Question: Produce a descriptive caption suitable for publication.
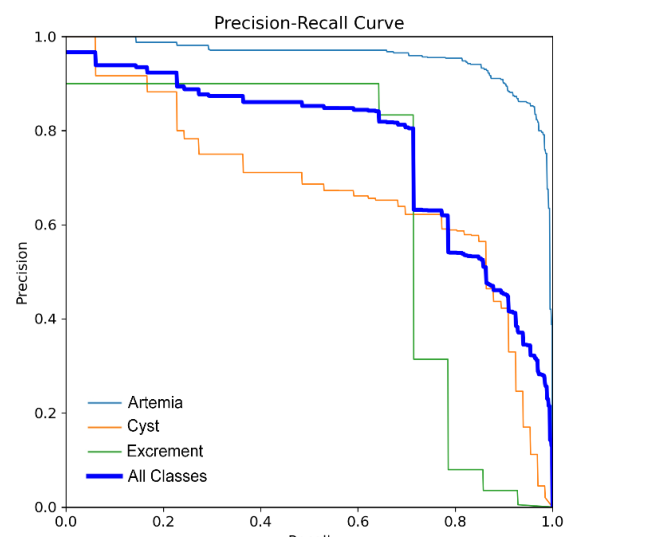
Answer: YOLOv5 Precision - Recall curve